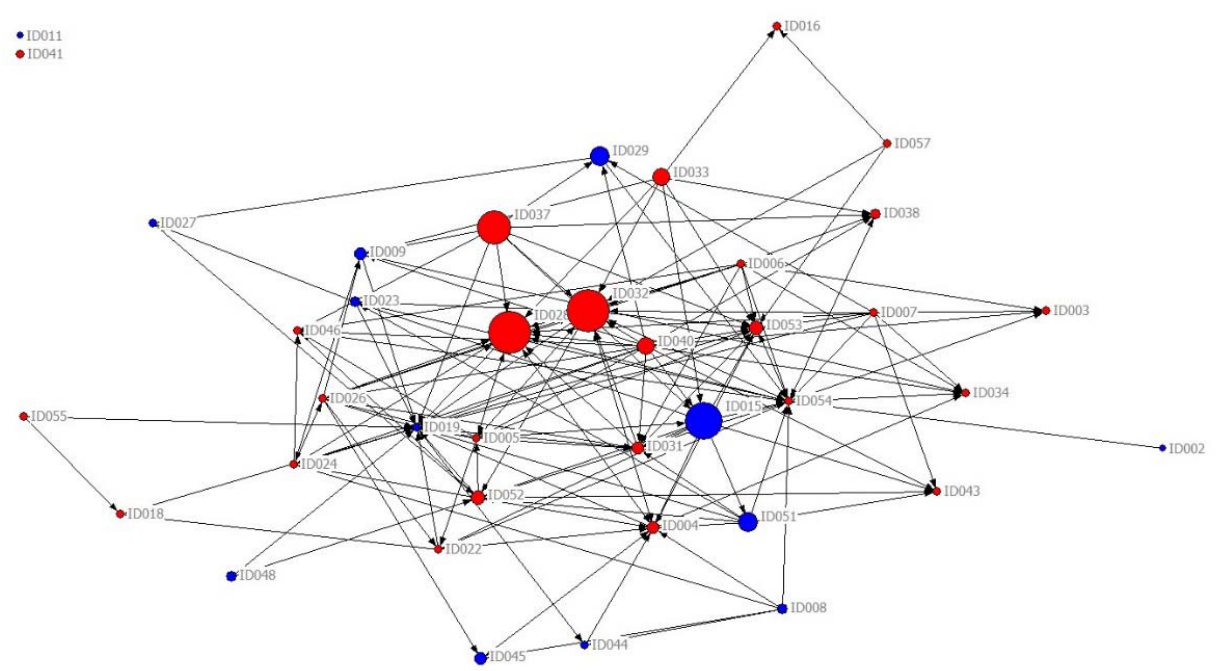
Figure 1. Technological knowledge network.